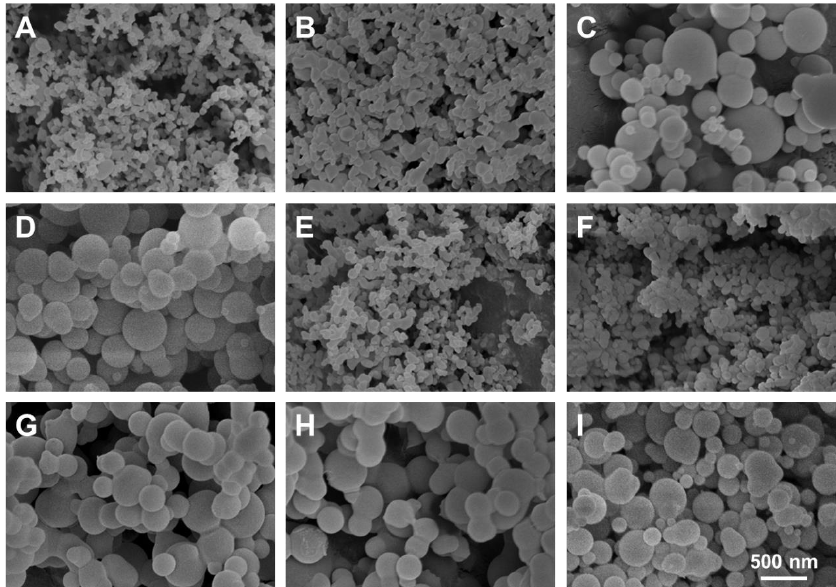
Figure 3. SEM images of samples prepared under different operating conditions (as shown in Table 3).